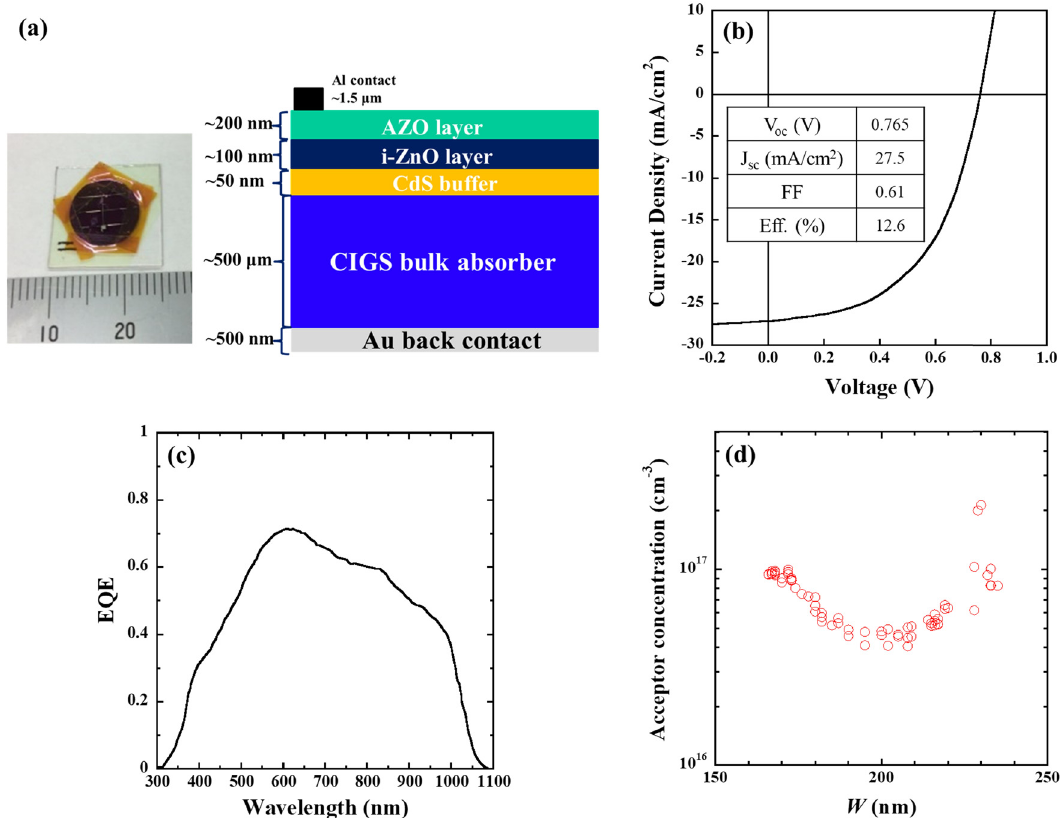
Figure 6: Properties of PV device based on CIGS single crystal. ( a ) Device structure, ( b ) J – V curve, ( c ) EQE spectrum, and ( d ) the net acceptor concentration versus depletion width W from CV measurement. The value of depletion width W at 0 V bias is 210 nm. The p - type conversion of CIGS ( x = 0.2 ) single crystal absorbing layer was carried out by Se -